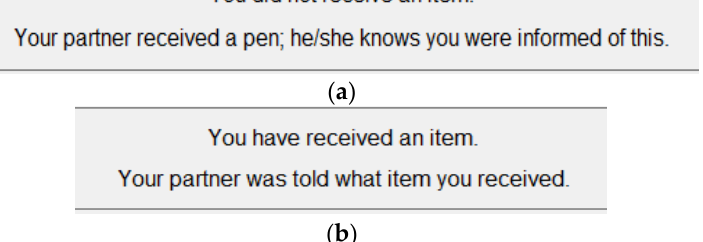
Figure 5. Control treatment messages. ( a ) Message to gift‐giver about dictator’s item; ( b ) Message to dictator about what their partner knows.